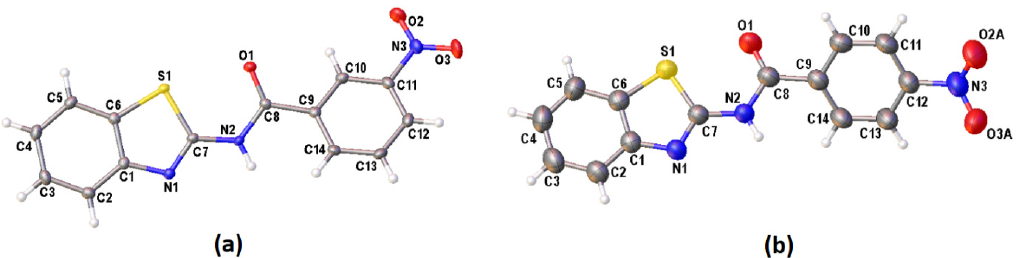
Figure 3. The molecular structures of ( a ) II and ( b ) III (disordered O atoms of the NO 2 substituent group were omitted for clarity), showing the atom-numbering schemes. Displacement ellipsoids are drawn at the 50% probability level.